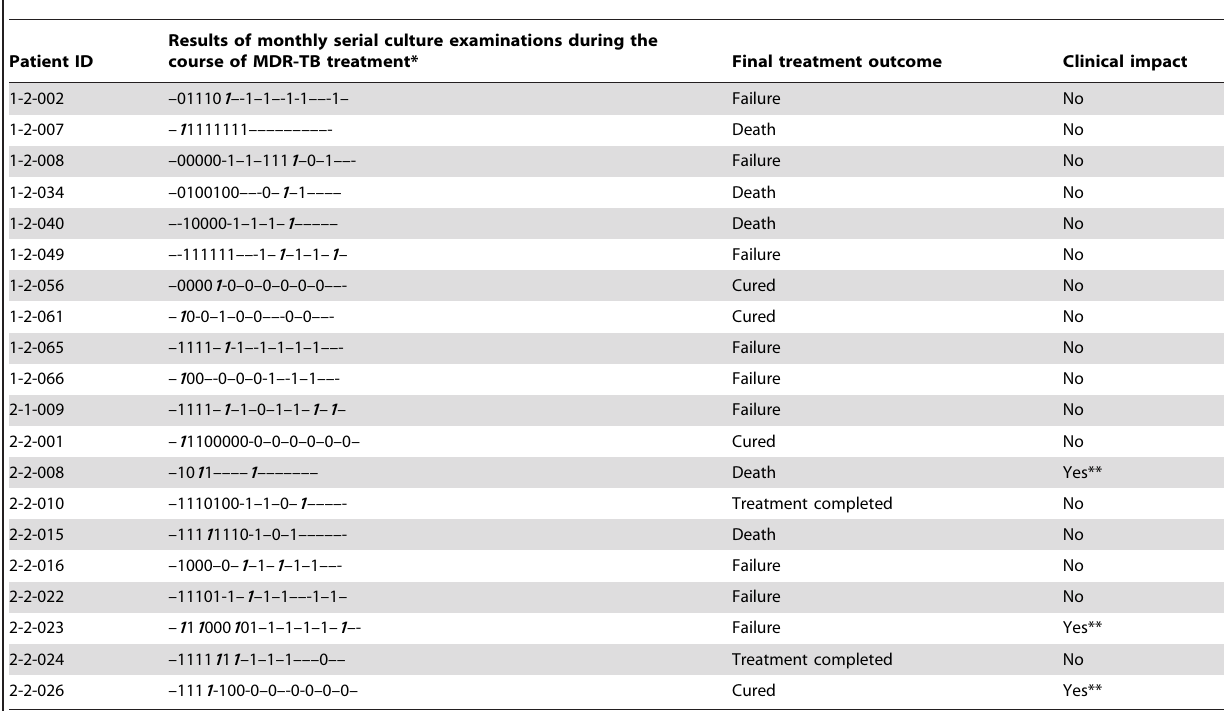
Table 3. Impact of examining only one specimen instead of two for culture during follow-up of multi-drug resistant tuberculosis patients, India, 2008–09.